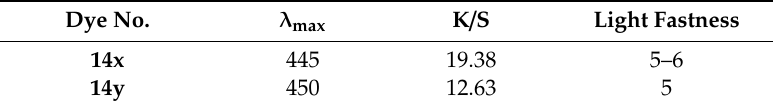
Table 4. Color strengths and light fastness of polyester